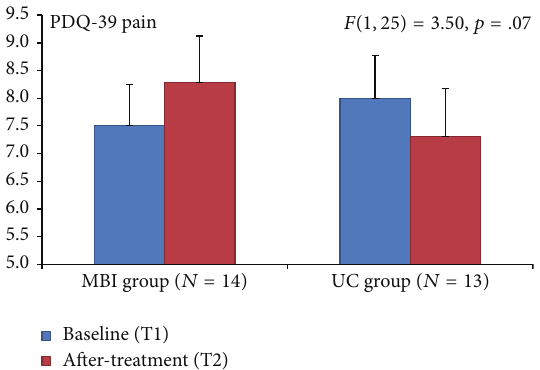
Figure 3: Parkinson’s Disease Quality of Life (PDQ-39) showed a marginal significant effect for the MBI